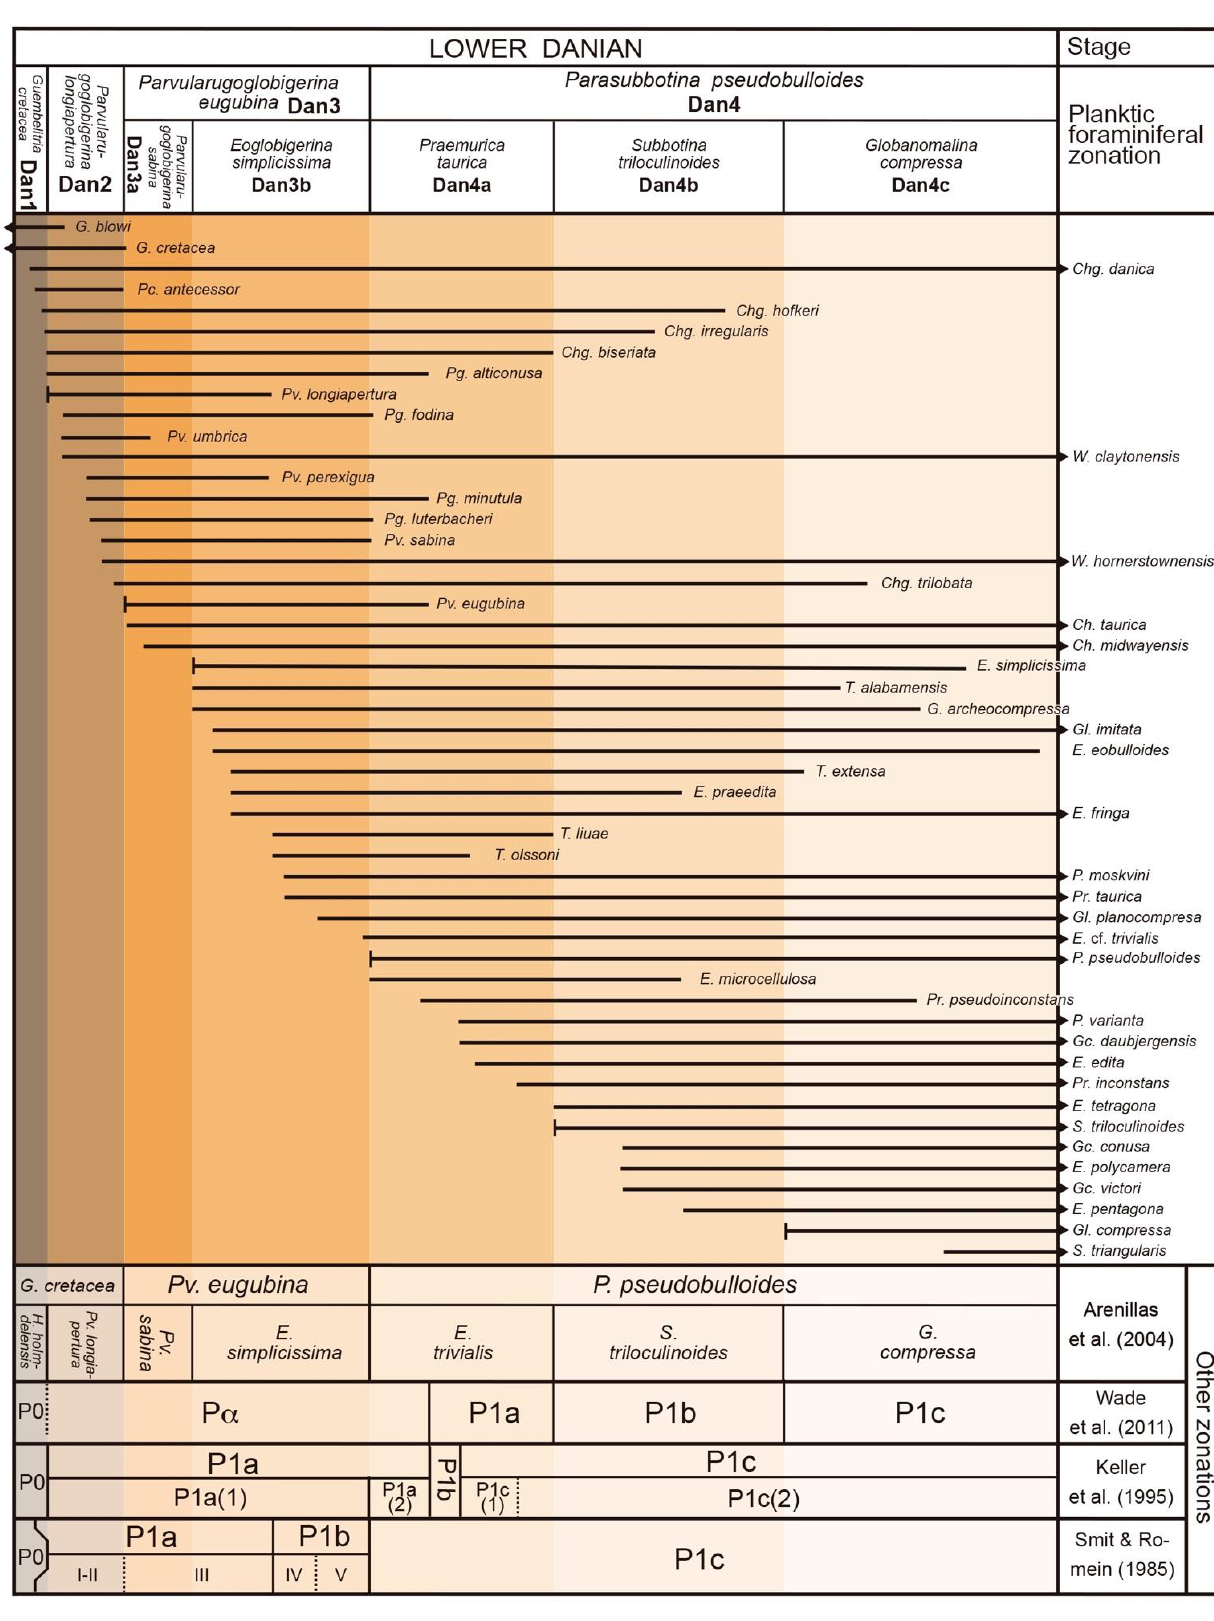
Figure 2. Qualitative biozonation proposed in this paper, and biostratigraphic ranges of early Danian planktic foraminiferal species based on high-resolution biostratigraphic studies (see references in text). Comparison with the most widely used P-biozonations: (1) Arenillas et al. [24]; (2) Wade et al. [2]; (3) Keller et al. [23]; (4) Smit and Romein [18].